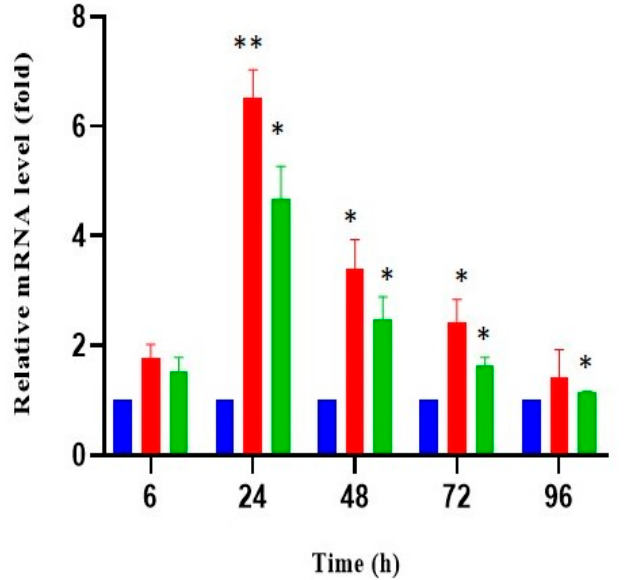
Figure 3. Levels of expression of cmalA and cmalB genes in control strain Mc-cmal-2075 and overexpressing strains Mc-cmalA-4 and Mc-cmalB-5. Values are the mean of three biological replicates. Error bars represent the standard error of the mean. Asterisks indicate significant differences: * p < 0.05 and ** p < 0.01.